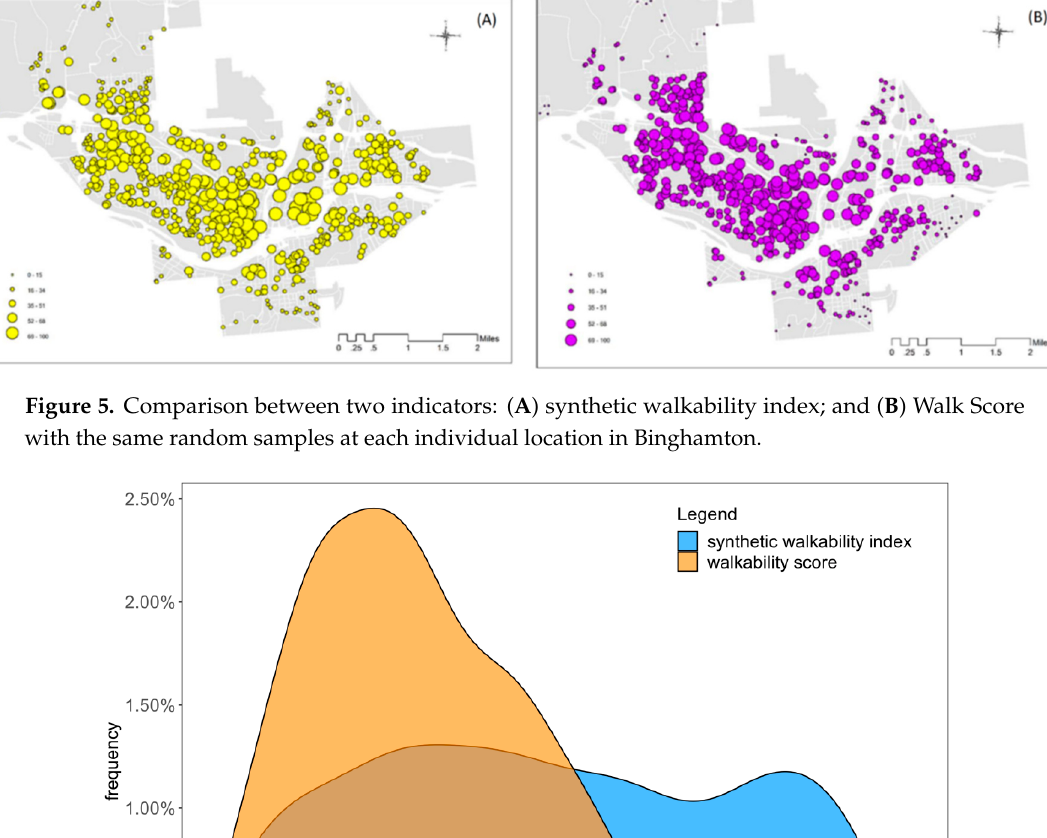
Figure 4. Spatial pattern of synthetic walkability index of the Greater Binghamton Area (showing the mean value at the block level, for illustration purposes only).